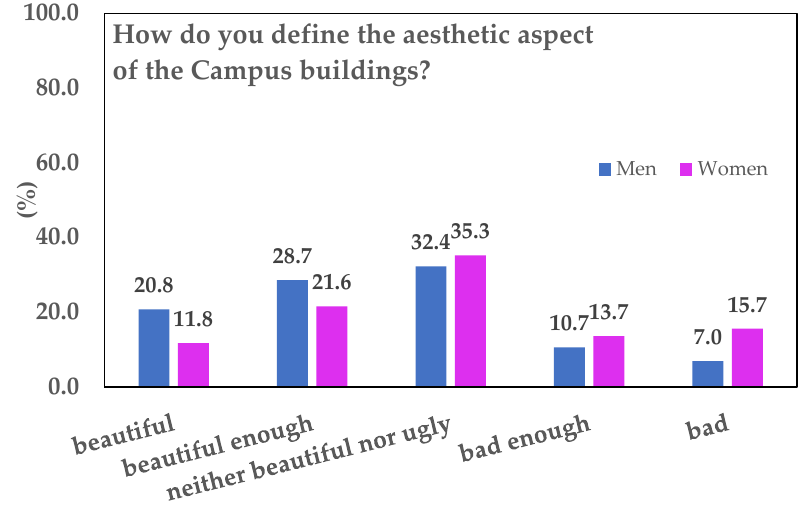
Figure 6. Aesthetic aspect of the Campus of Fisciano.